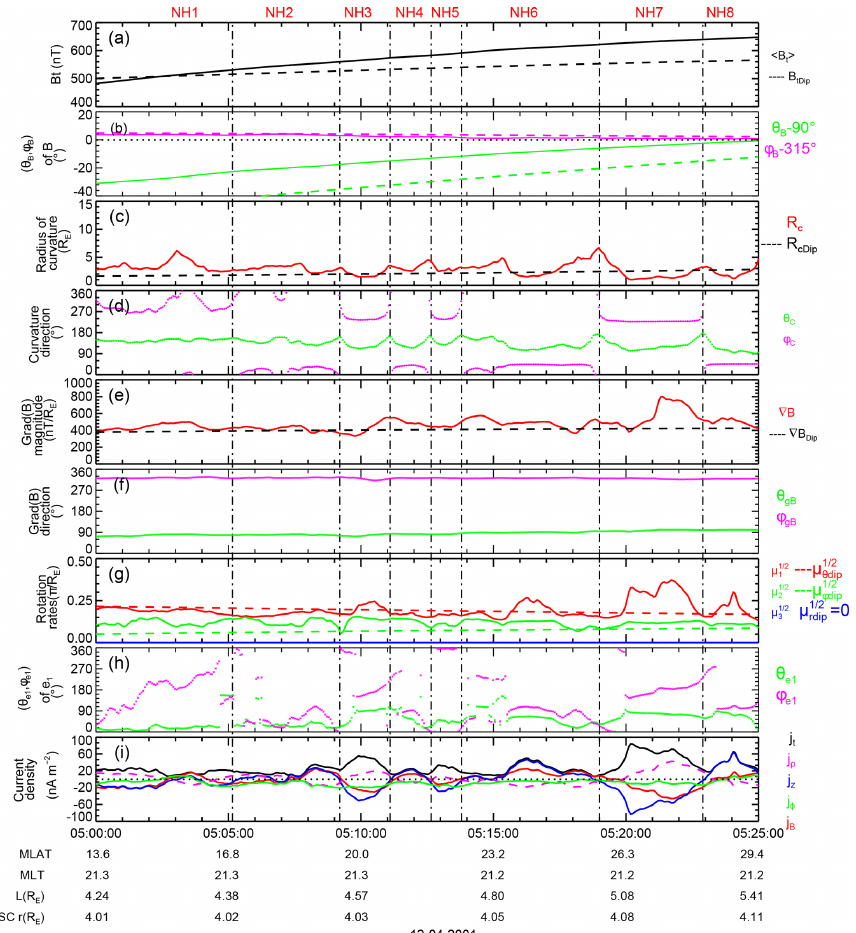
Figure 2. Geometry of the magnetic field and the current distribution in the Northern Hemisphere (NH) region on 12 April 2001. (a) Average magnetic strength B t at the center of the Cluster tetrahedron (black solid line) and the calculated strength B tDip of the dipole geomagnetic field (black dashed line). (b) Direction angles ( θ B , φ B ) of the magnetic field. 90 and 315 ◦ are reduced respectively for θ B and φ B to better indicate the magnetic-field variation. The polar angle and azimuthal angle of dipolar fields are also show in dashed lines. (c) Radius of curvature, R c (red solid line), and the calculated radius of curvature, R cDip , of the dipole geomagnetic field (black dashed line). (d) Direction angles ( θ c , φ c ) of the curvature of the MFLs. (e) Value of the gradient of magnetic-field strength for the real magnetic field (red solid line) and dipole geomagnetic field (black dashed line). (f) Direction angles ( θ g B , φ g B ) of the gradient of magnetic-field strength. (g) Maximum, median, and minimum rotation rates of the measured magnetic field (solid lines) and dipole geomagnetic field (dashed lines). (h) Direction angles ( θ e 1 , φ e 1 ) of the maximum rotation rate. (i) Total current density j t (black line) and the three components j ρ (magenta line), j ϕ (green line), and j z (blue line) in local cylindrical coordinate system, respectively. The red line is the field-aligned component j B (red